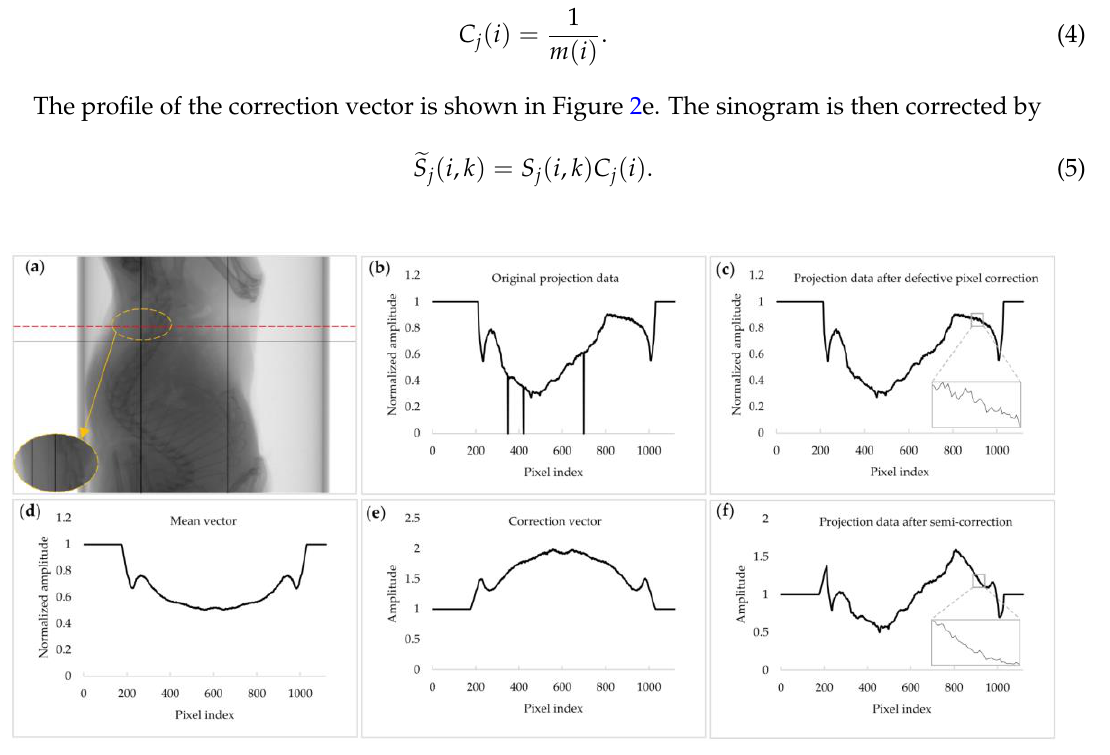
Figure 2. An example of mis-calibrated pixel correction. ( a ) A projection image of a rat taken with a FPD. The magnified region shows some defective pixels appearing as vertical lines. ( b ) The original projection data along the dashed line in Figure 2a. ( c ) The projection data after the defective pixel correction. ( d ) The mean vector. ( e ) The correction vector. ( f ) The projection data after the semi-